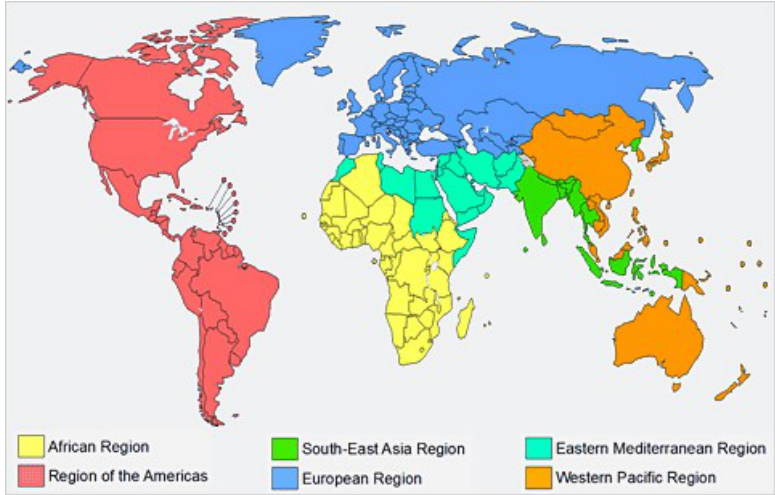
Figure 1. WHO Regions: WHO Member States are grouped into six regions. Each region has a regional office. The map shows the WHO regions and the location of the regional offices (https://www.who.int/about/regions/en/).